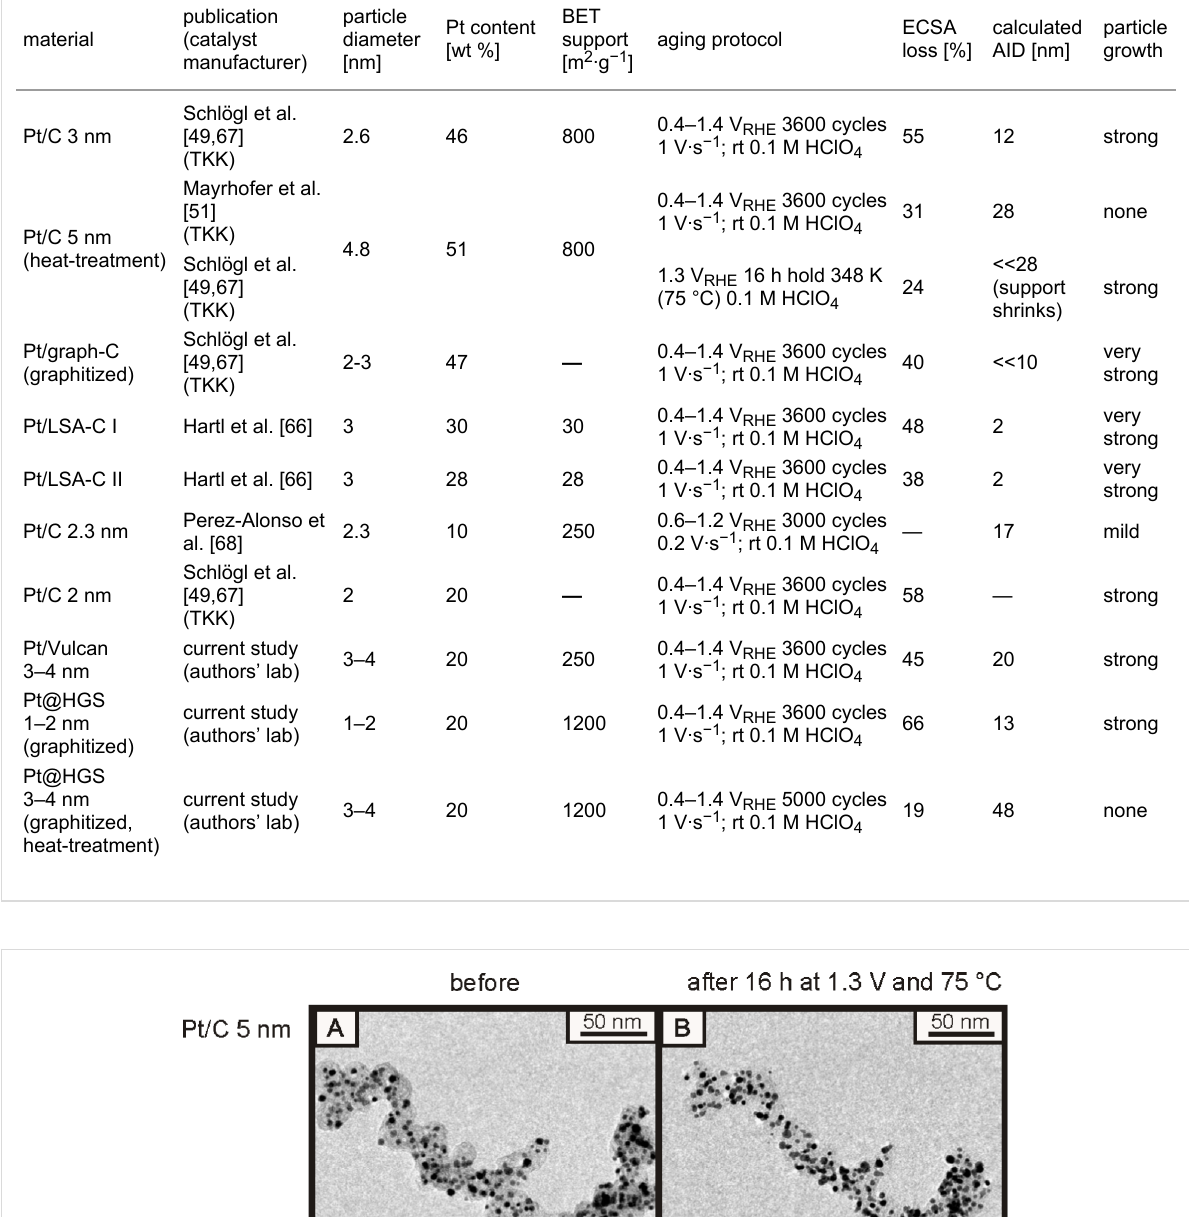
Table 2: Stability data of the three Pt/C catalysts of this study, as well as data from the four catalysts depicted in Figure 9 are summarized. Additional- ly, three further catalyst materials are included. Information about particle growth was deduced from IL-TEM, while the ECSA loss was determined via thin-film half-cell tests. The data from investigations of Schlögl et al. [49,67], Mayrhofer et al. [51], Hartl et al. [66] and Perez-Alonso et al. [68] were included in the comparison, and the AID was also calculated for these studies by using Equation 1. “rt” indicates experiments at room temperature.